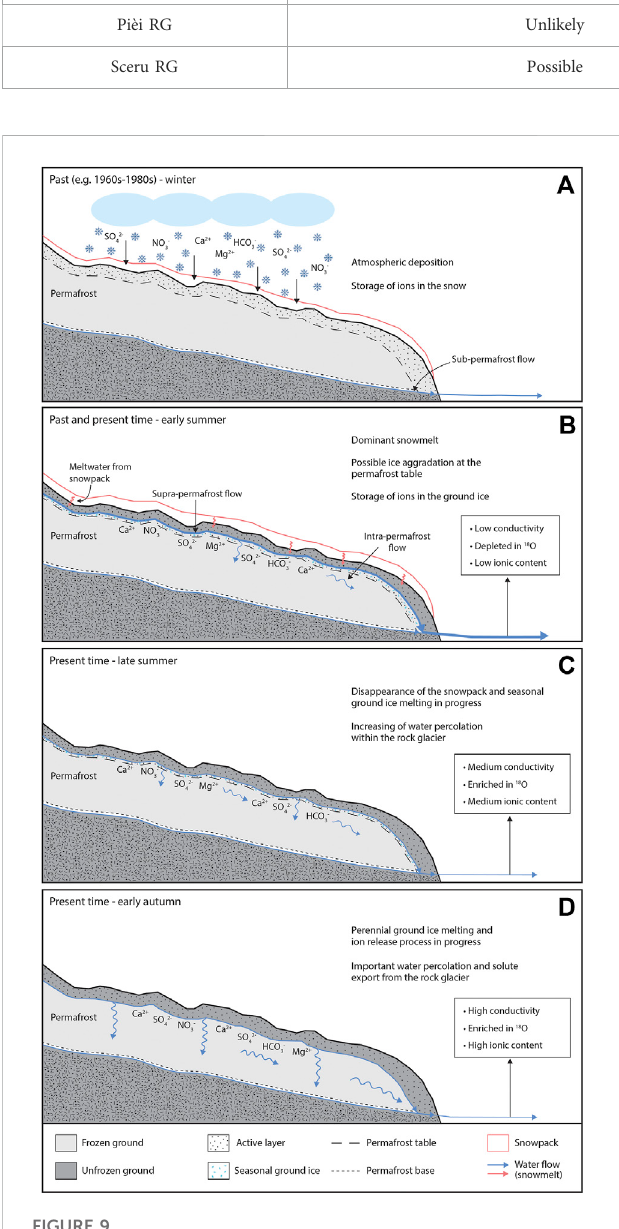
FIGURE 9 Conceptual model of the main hydro-chemical processes taking place in an active rock glacier, divided into four time phases: (A) winter time in the past, (B) early summer in past and present time, (C) late summer in present time and (D) early autumn in present time. This fi gurereferstotheconceptualmodelsproposedbyWilliamsetal.(2006) and Colombo et al.